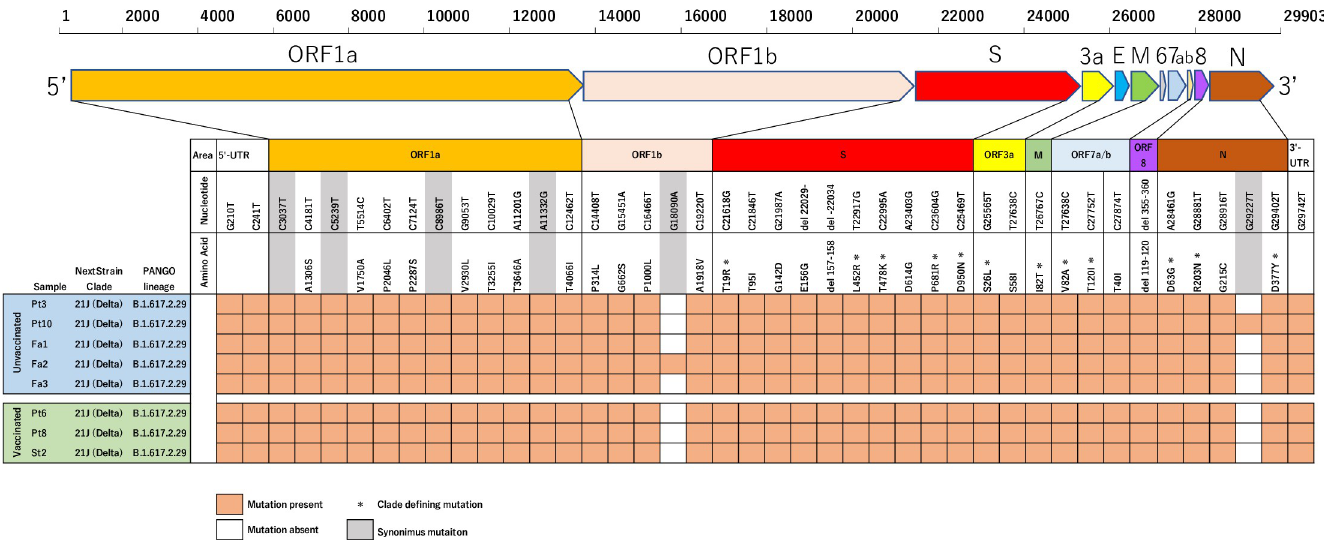
Fig 3. Mutation map of amino acids and nucleotides for the samples from SARS-CoV-2 infected persons. All mutations identified in the whole-genome sequencing are shown. The upper row shows all nucleotide mutations including synonymous mutations. The lower row shows the amino acid mutations caused by nonsynonymous nucleotide